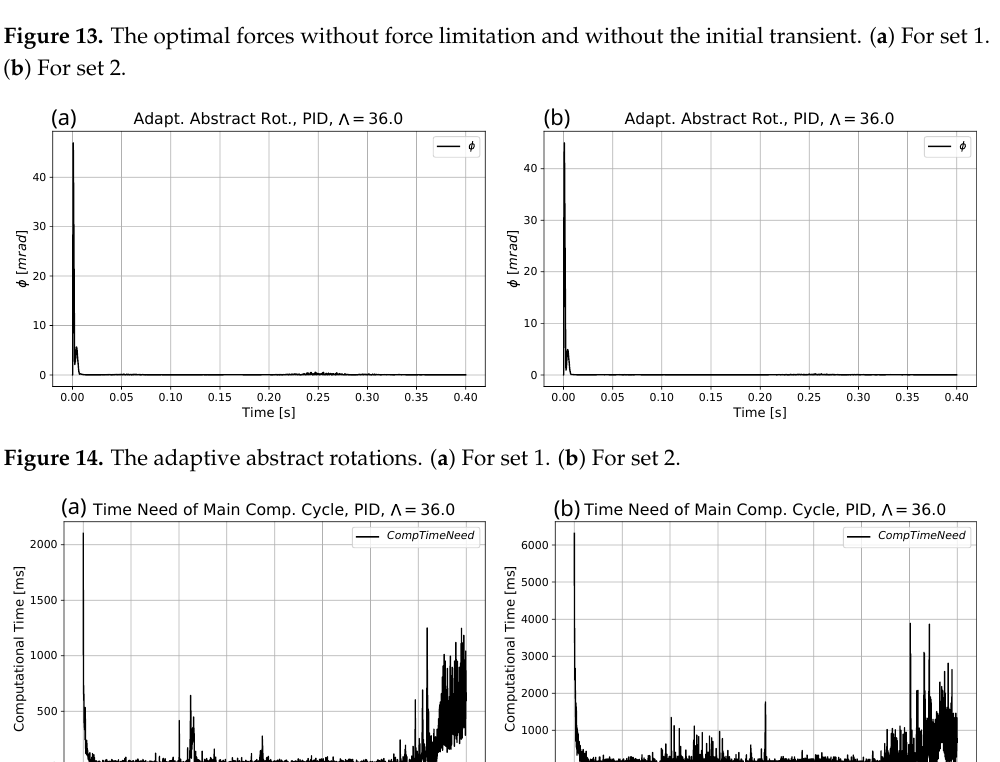
Figure 15. The computational time need of the main cycle without force limitation. ( a ) For set 1. ( b ) For set